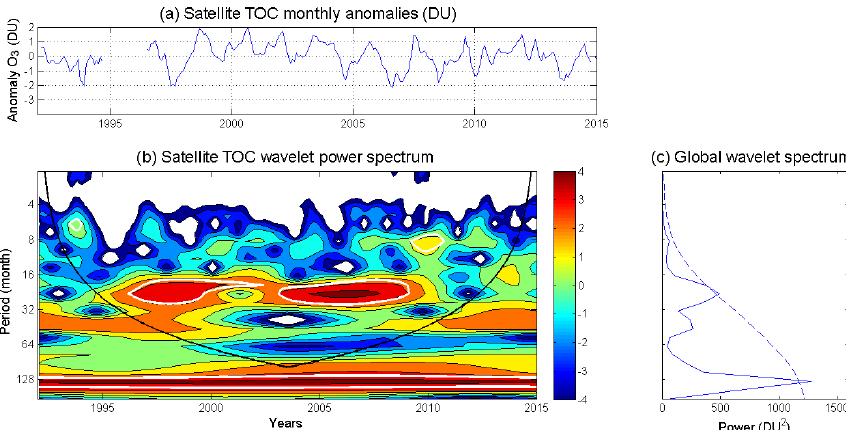
Figure 6. (a) The satellite TOC monthly anomaly time series used for the wavelet analysis over Southern Space Observatory between 1992 and 2014. (b) The wavelet power spectrum of (a) using the Morlet wavelet, normalized by 1 /σ 2 . The left axis is the Fourier period (in month), the power wavelet scale is on the right axis, and the bottom axis is time (year). The white contour encloses regions of greater than 95% confidence level and the U-shaped curve indicates the cone of influence. (c) The global wavelet spectrum of (a) , where the dashed line is the 95% confidence